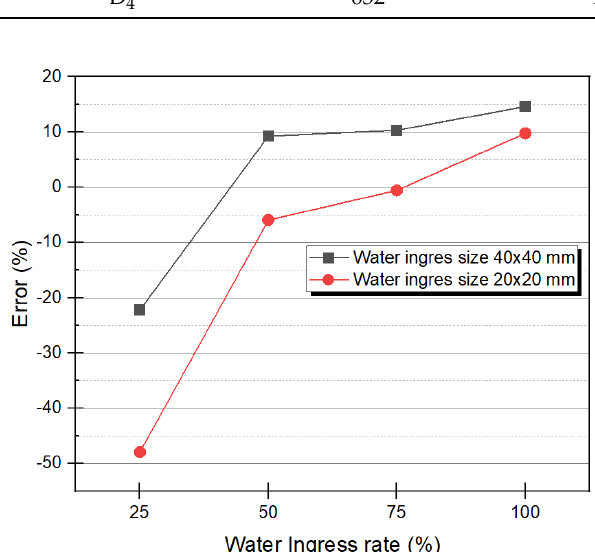
Figure 10. A binarized image at a modulation frequency of 0.1 Hz to calculate the number of pixels in a region.